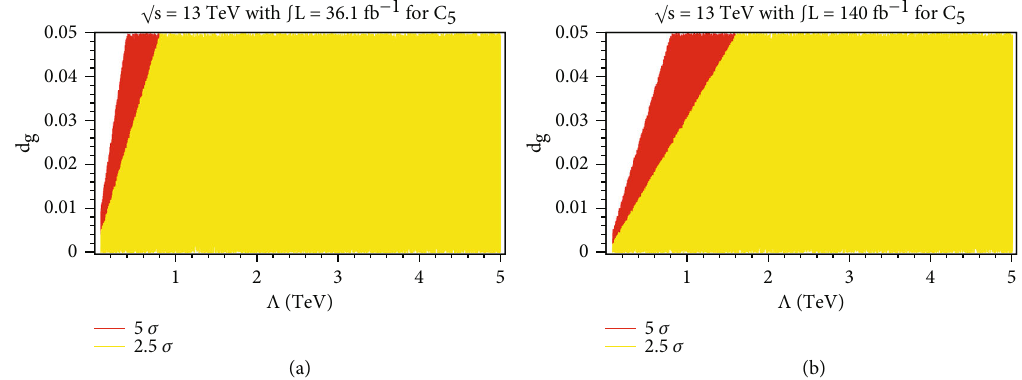
Figure 4: d vs. Λ for observable C g